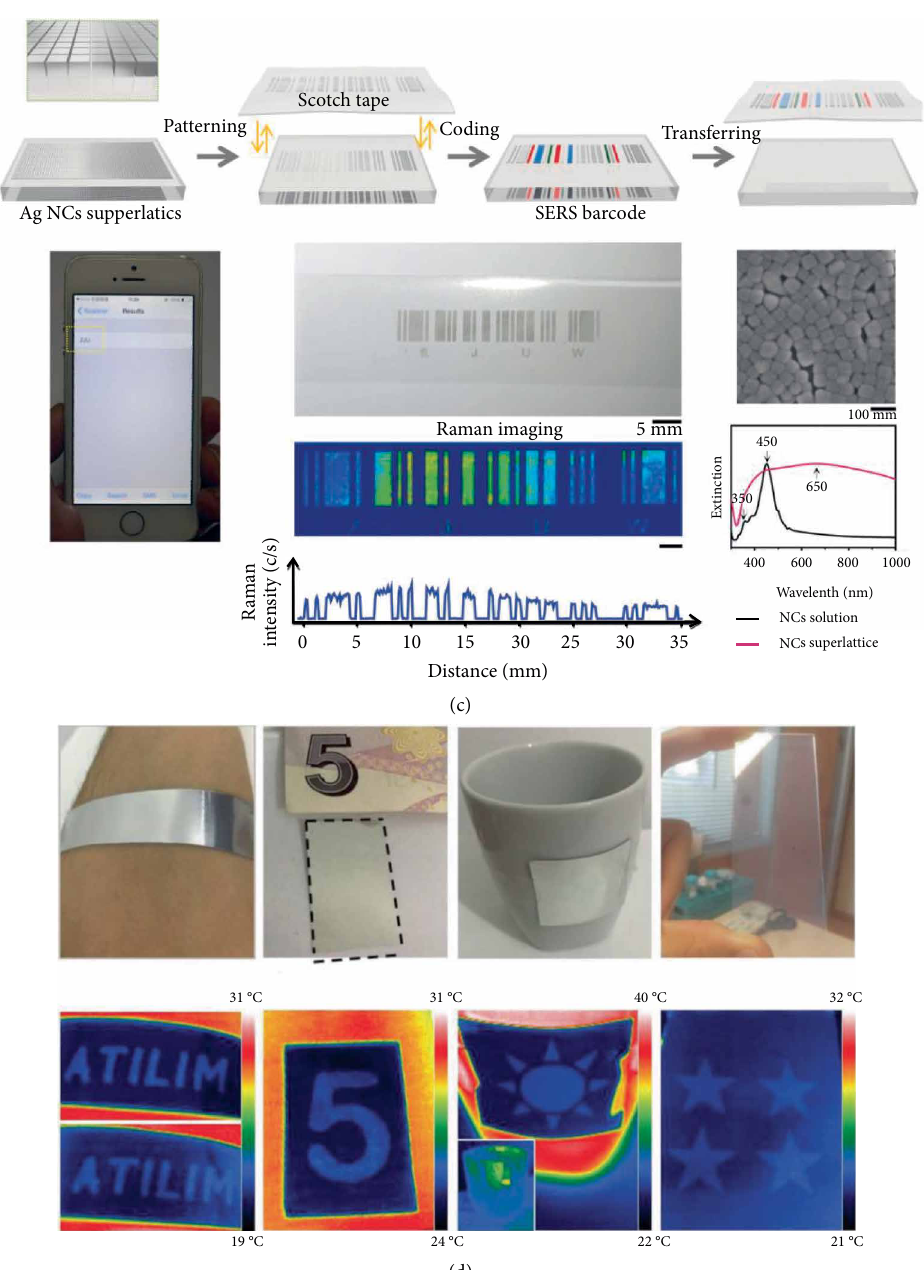
Figure 9: (a) (i) SEM images, (ii and iii) x - and y -polarized 2D SERS imaging of different molecularly encrypted nanostructures formed by horizontal and vertical Ag nanowires. Adapted from [191] and (b) homogeneous plasmonic anti-counterfeiting security labels. Adapted from [192]. (c) Schematic illustration and optical image of the fabrication of the SERS barcode and its application. Adapted from [194]. (d) Photograph and thermal image of alternative mirror layers. Adapted from